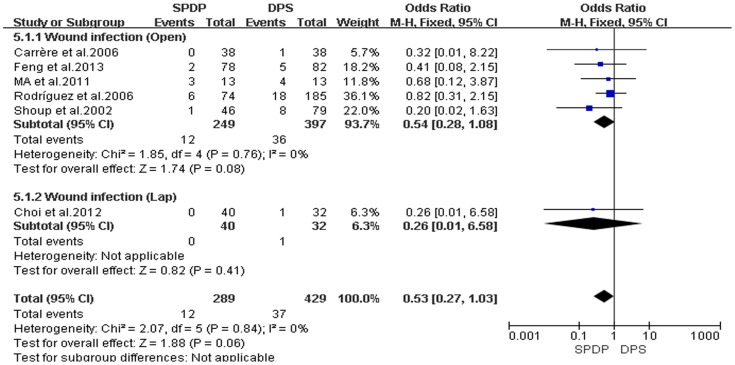
Wound infection (IV, Inverse variance; M-H, Mantel-Haenszel; CI, Confidence Interval; SD, standard deviation).